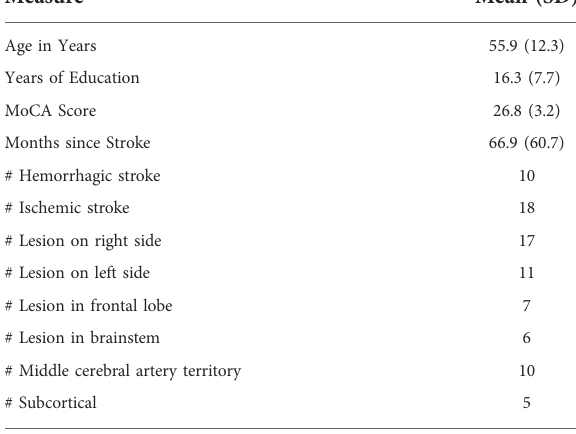
TABLE 1 Demographic information for the participants. Mean values are shown with standard deviation values provided in brackets. Note MoCA refers to Montreal Cognitive